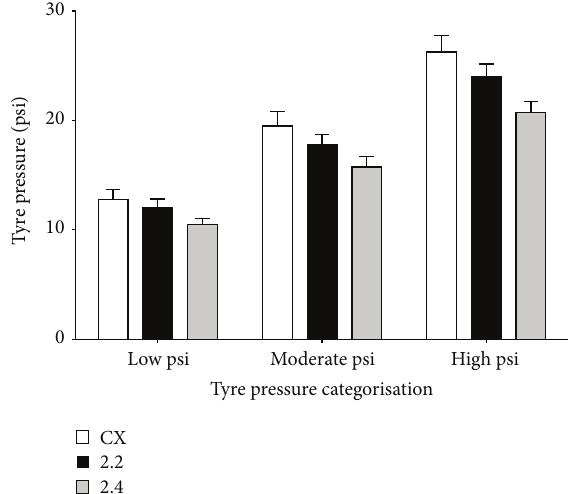
Figure 3: Comparison of the three tyres and the respective inflation pressures